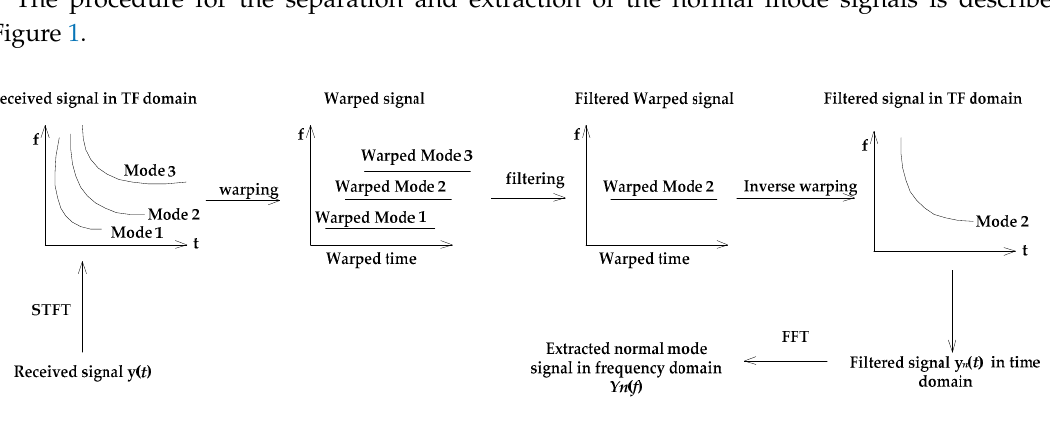
Figure 1. The procedure for the separation and extraction of the normal mode signals using a warping transformation.